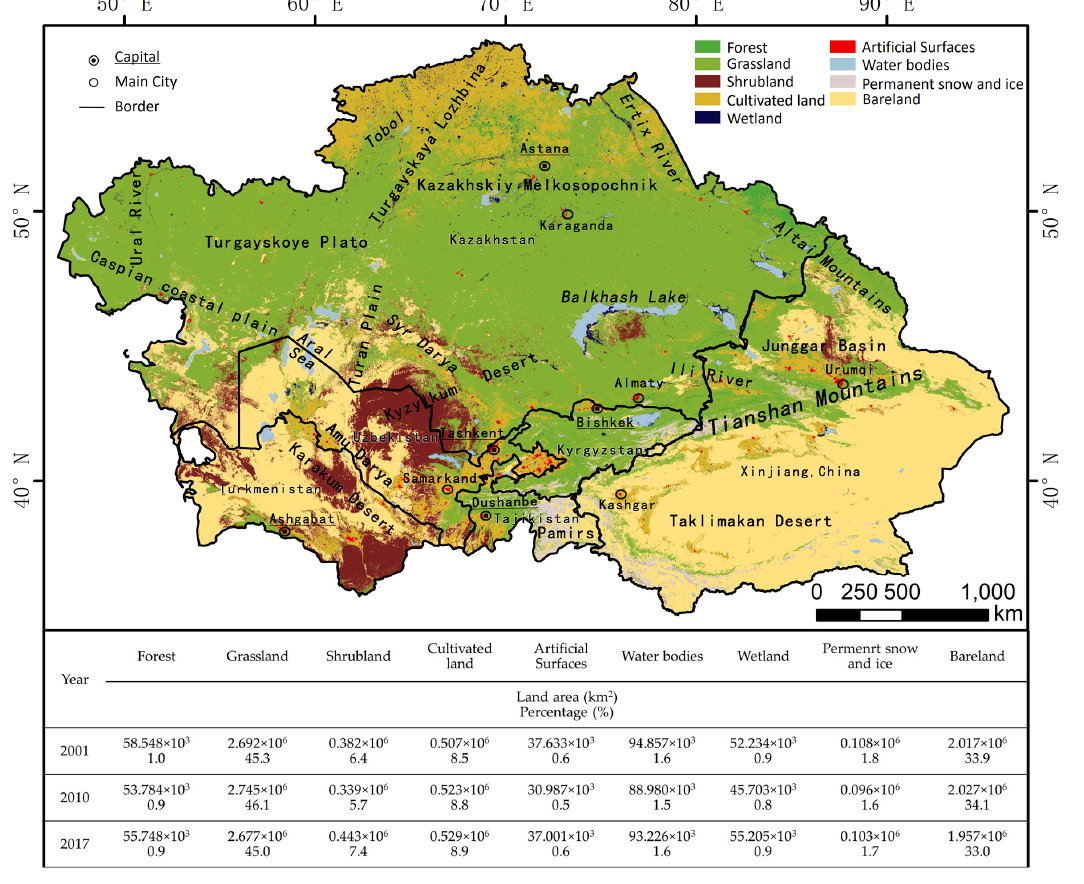
Figure 5. Land cover classification in 2017, with computed area (km² and %) for land cover classes 2001, 2010 and 2017.